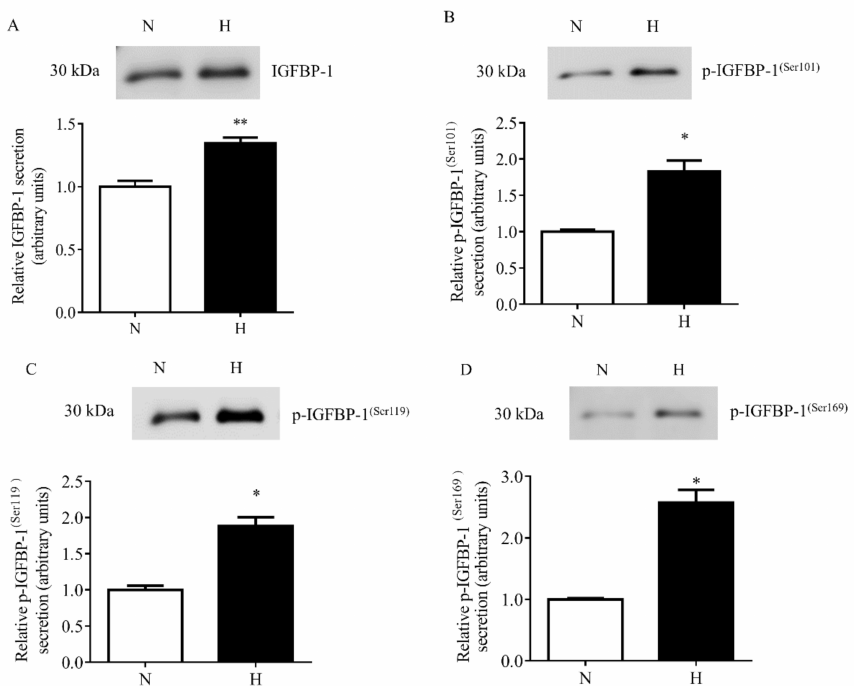
Figure 3. The effect of hypoxia on IGFBP-1 secretion and phosphorylation in decidualized primary HESCs. Representative Western blot of total and phosphorylated IGFBP-1 secreted by decidualized primary HESCs under control normoxia (N) (incubator air) or hypoxic (H) (1% O 2 ) conditions ( n = 4 each). Western blot analyses were performed for total ( A ) and pIGFBP-1 (Ser101) ( B ), pIGFBP-1 (Ser119) ( C ), and pIGFBP-1 (Ser169) ( D ), using equal volume of conditioned media (CM) (36 µ L) from control and hypoxia treated cells. The Western blot data are summarized in the bar graphs. Values are given as mean + SEM. *, p < 0.05; **, p = 0.001–0.05 versus control as per Student’s paired t